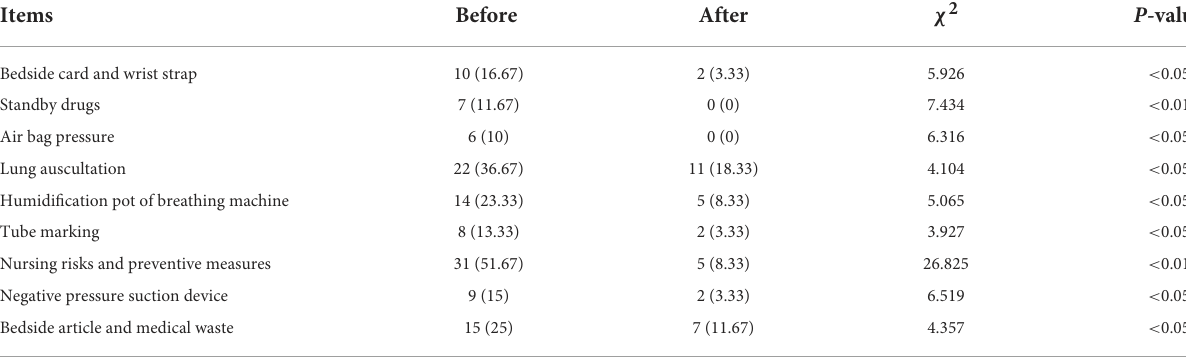
TABLE 3 Comparison of item omission in nursing handover before and after using checklist [Times (%)].